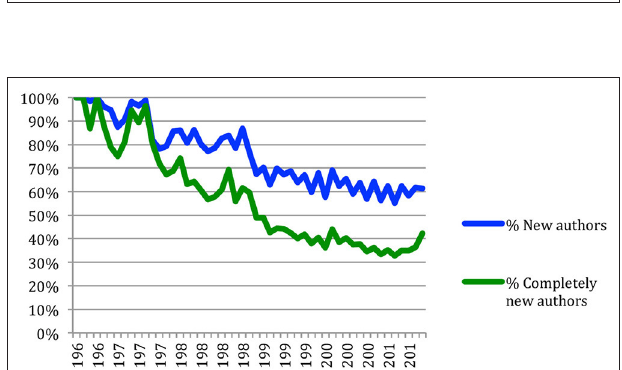
FIGURE 22 | Percentage of new authors and completely new authors over